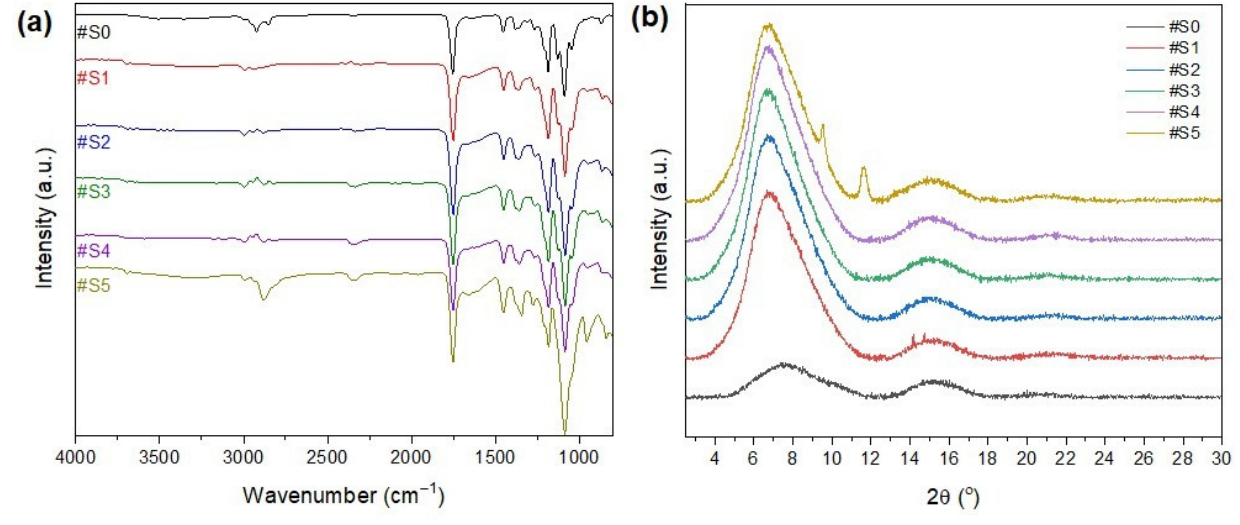
Figure 5. ( a ) FT-IR spectra and ( b ) XRD patterns of #S0, #1S, #2S, #3S, #S4, and #S5.